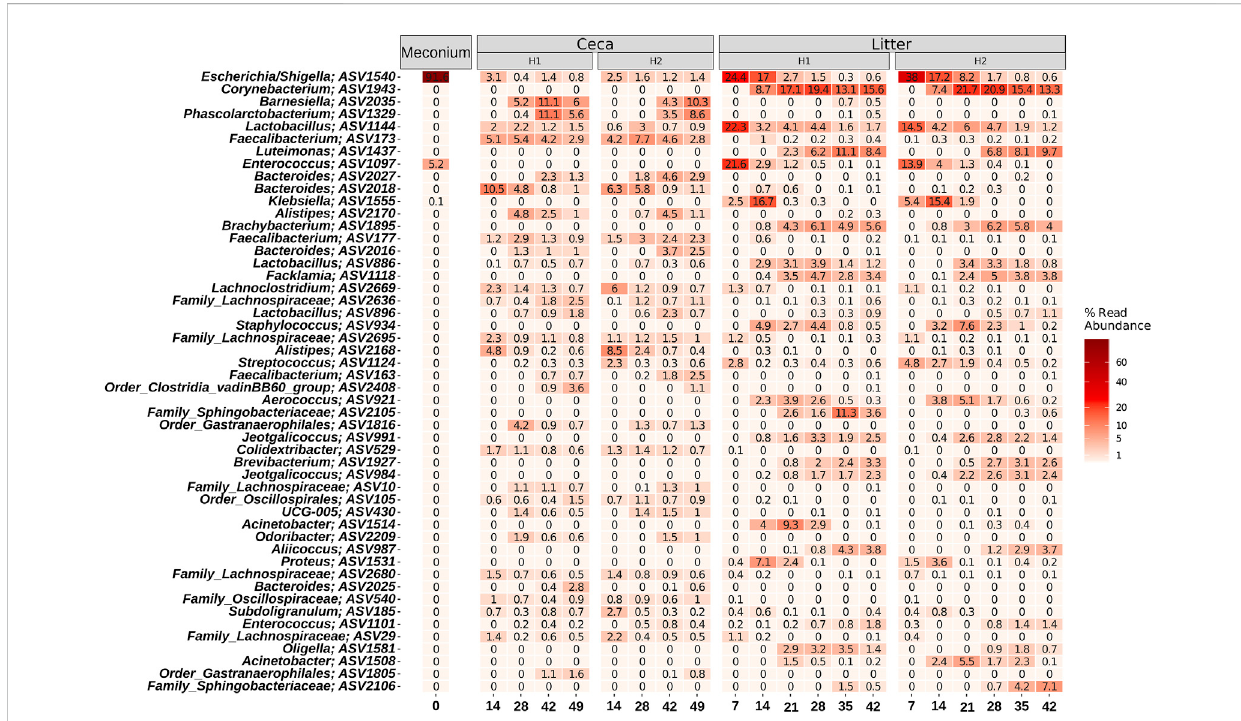
Heatmapshowingtherelativeabundanceofthe50mostabundantASVs.Samplesweregroupedbydaysandsplitbysampletype(Meconium,Ceca, Litter).Relativeabundancewasnormalizedbytotalsumscalingandthemeanforeachsamplegroupisdepicted.TaxonomyoftheASVsisindicatedatthe genus levels or at the lowest rank that could be assigned con fi dently (Bootstrap support above